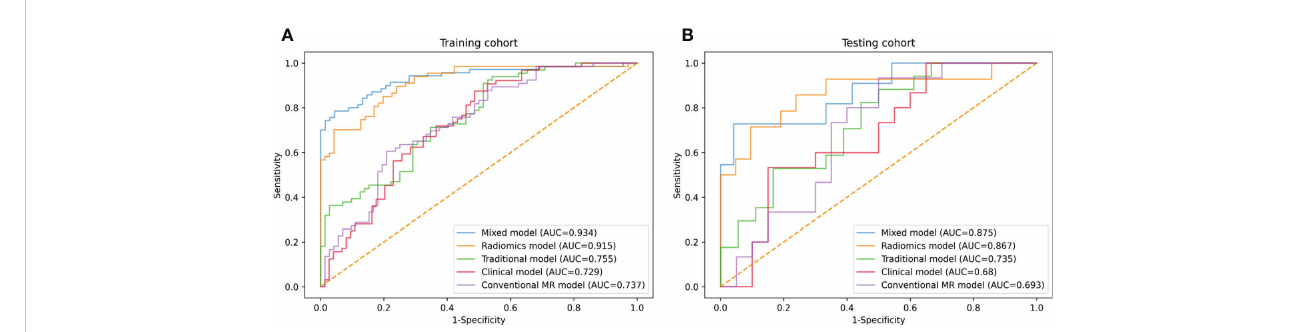
TABLE 4 Predictive performances of the fi nal models in the development and testing cohorts.